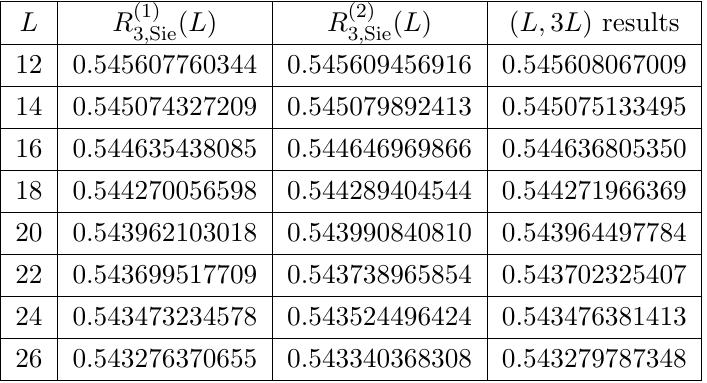
( L ) and R (2) ( L ) compared with the direct ( L; 3 L ) level- 3 ; Sie 3 ; Sie